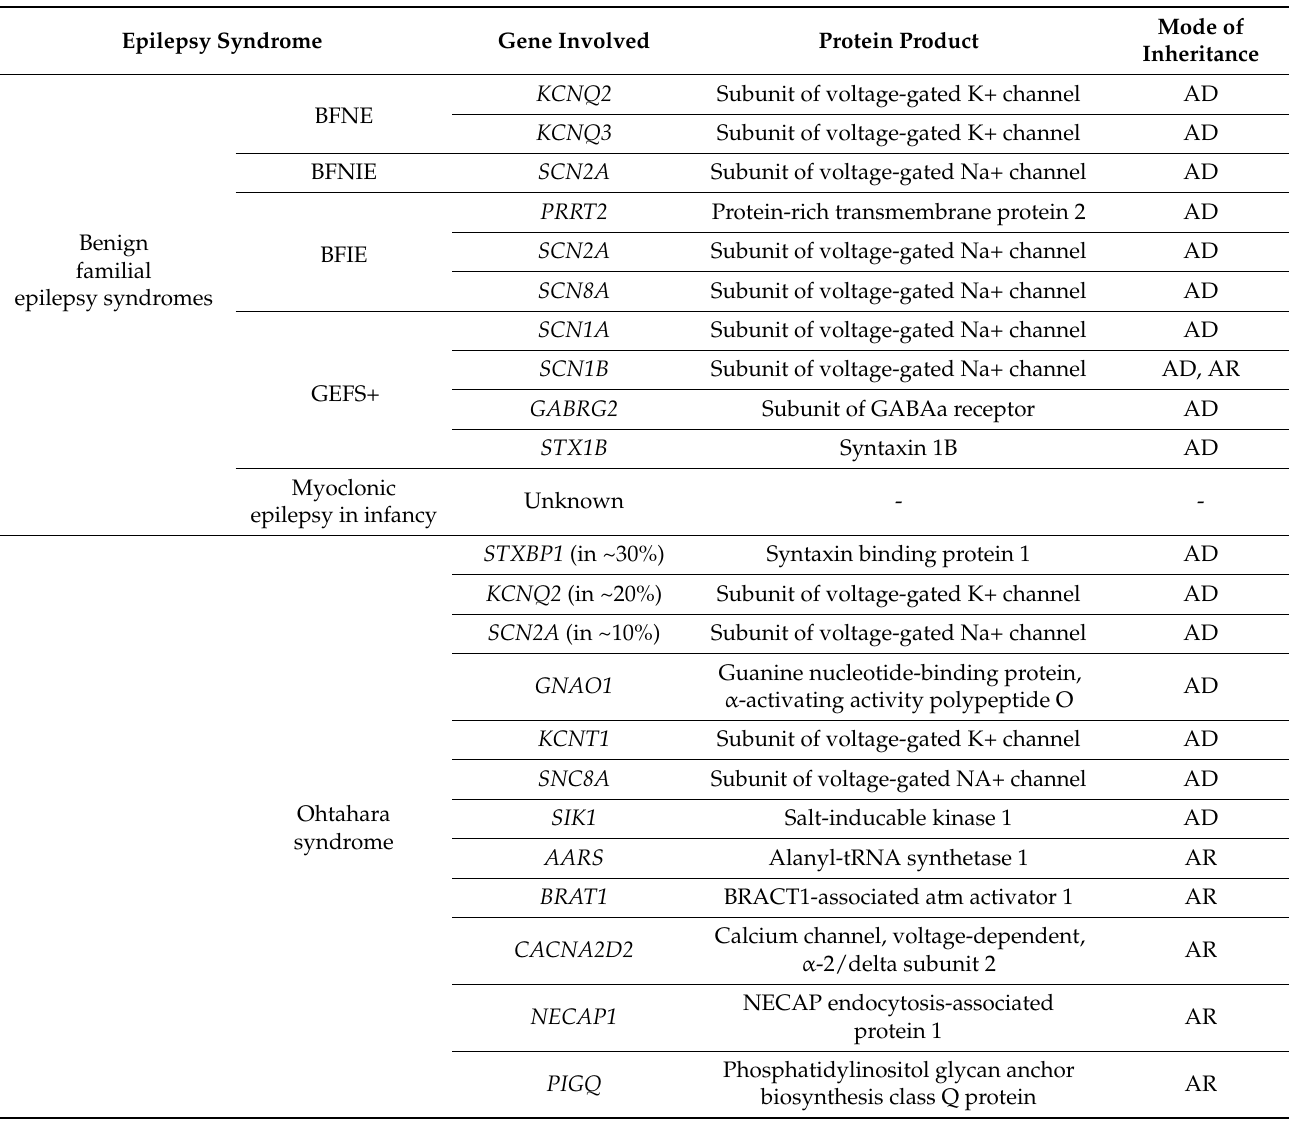
Table 1. Epilepsy syndromes with onset during the neonatal period and/or infancy and the commonly associated genes (list is not exhaustive). The most commonly occurring genes within each electroclinical syndromes are listed first with percentages in bracket followed by less commonly occurring genes listed in alphabetic order and according to